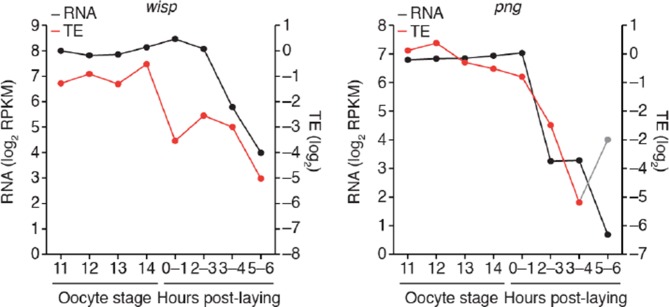
DOI:
http://dx.doi.org/10.7554/eLife.16955.020